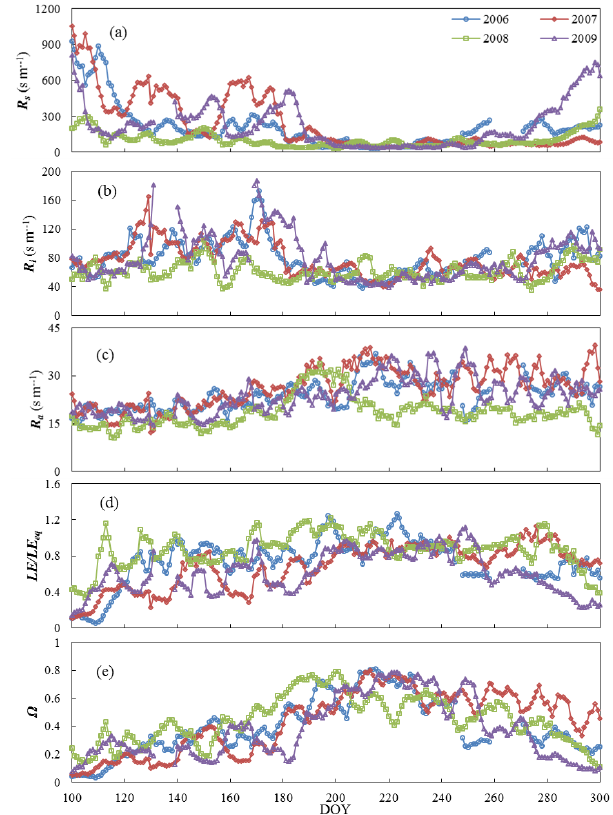
Figure 5. Seasonal dynamics of the midday (10:00–15:00LST) mean surface resistance ( R s ) , climatological resistance ( R i ) , aero- dynamic resistance ( R a ) , LE / LE eq , and decoupling coefficient ( (cid:127)) (5-day running average) across the growing seasons from 2006 to 2009.